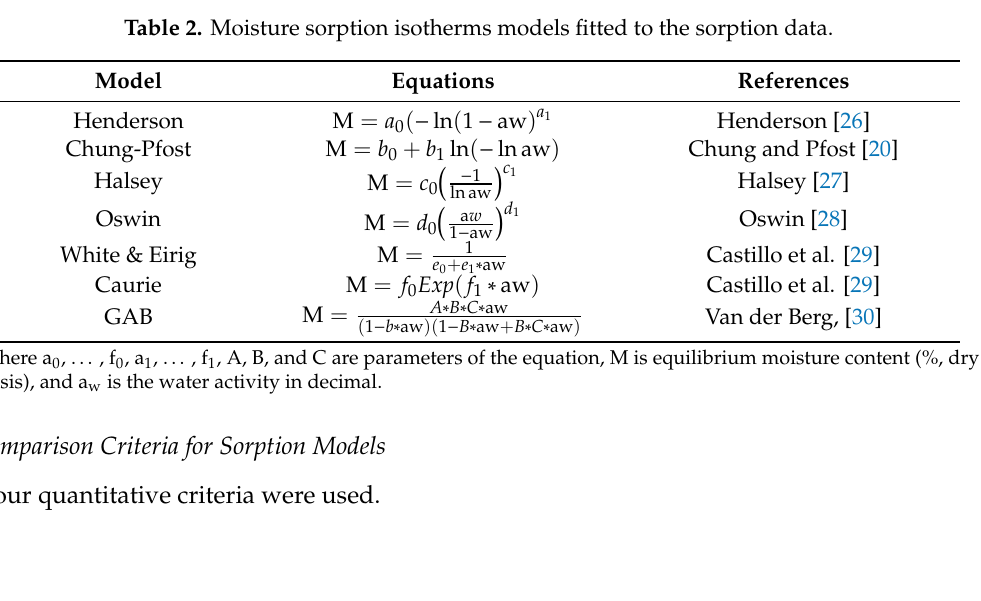
Figure 1. Sketch of experimental set-up.